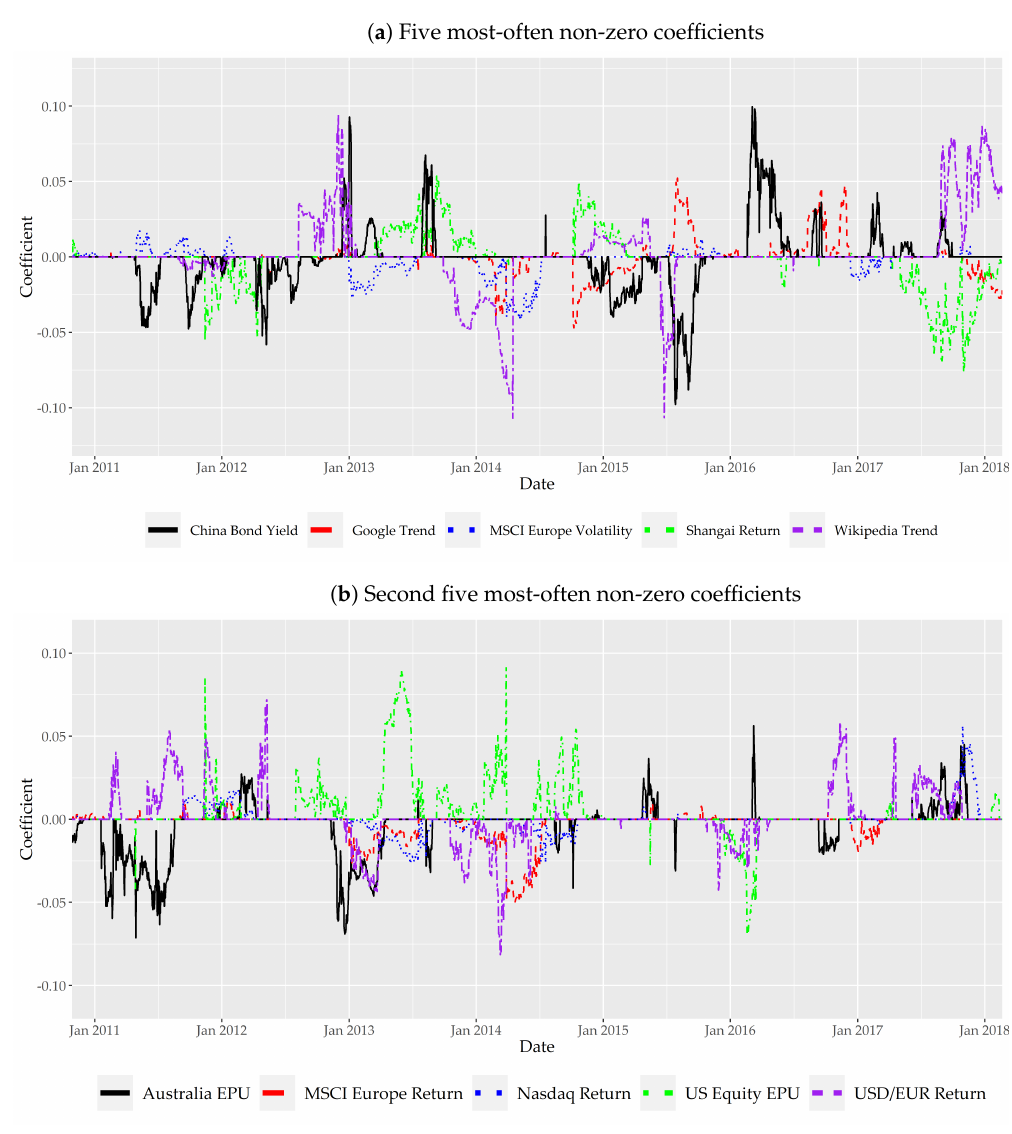
Figure 1. Rolling window PC-LASSO coefficients with market/factor type components. Notes: The window size is 200 observations. All variables are standardized in each window separately. For comparability λ = 15 and r = 0.7 across all windows. The ECB the Chinese central bank rates have not been included in the analysis, as they often do not vary within windows. The coefficients on a given date correspond to the window whose 100th observation corresponds to that date. In the first panel are the coefficients of the five independent variables whose coefficients are most often non-zero in the rolling window estimation (for example, the China bond yield is the variable whose coefficient is non-zero the most times; that is, in 994 out of the 2673 rolling window estimations); in the second panel are the five variables with the next highest numbers of non-zero coefficients. Morgan Stanley Capital International’s (MSCI) Europe volatility index and the USD/EUR return have equal numbers of non-zero coefficients